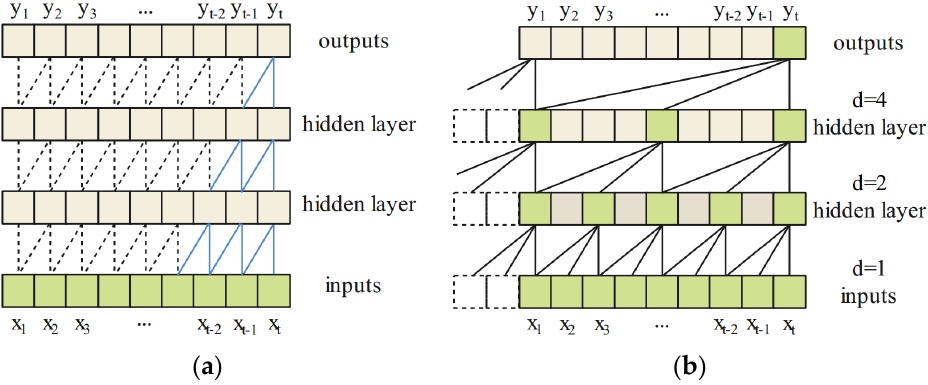
Figure 5. Illustration of casual convolution ( a ) and dilated casual convolution with dilated factors = 1, 2, and 4 and filter size = 3 ( b ).